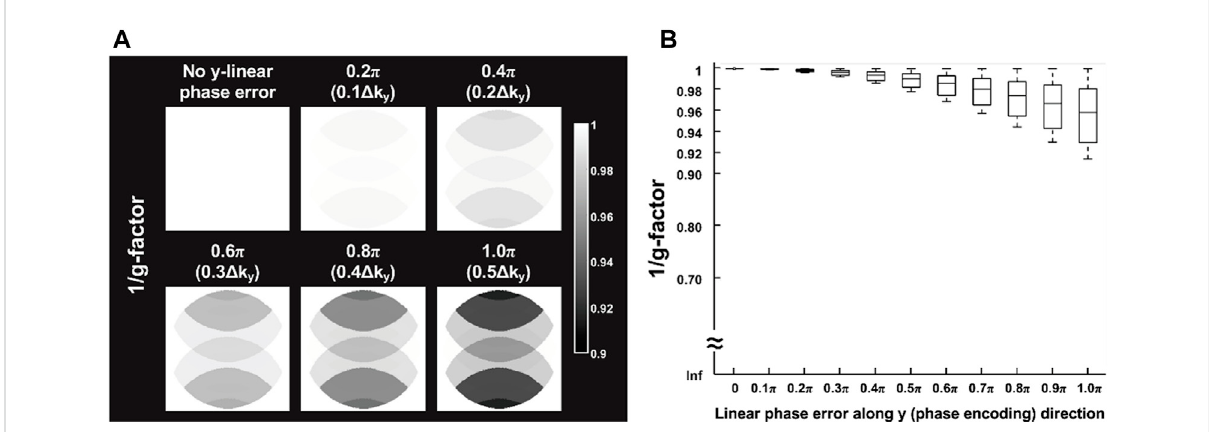
FIGURE 3 (A) Simulation results of six representative 1/g-factor maps corresponding to relative 0 to 0.5 Δ k y shifts (with increment of 0.05 Δ k y ) between positive and negative echoes for the reconstruction performance of proposed 2D Nyquist ghost correction method. (B) The box plot of the measured 1/g-factor maps from an ROI covering entire area of the phantom for different linear phase errors along PE direction (from 0 to π with an increment of 0.1 π ). The worst case reveals a mean SNR loss less than 5% and maximum SNR loss less than 10% for certain pixels. Nevertheless, they-linearphaseerrorisoftenlessthan π (e.g.,0.5 π maximum)andtheoverallSNRlossislessthan3%fortheproposedcorrectionmethod.Without the presence of y-linear phase error, the proposed correction method will not cause any SNR loss and it is still robust for correcting the phase error along x (Figure 3A). Therefore, the proposed method can be an alternative for enabling self-referenced 2D Nyquist ghost correction with only negligible loss of SNR associated with its reconstruction algorithm.